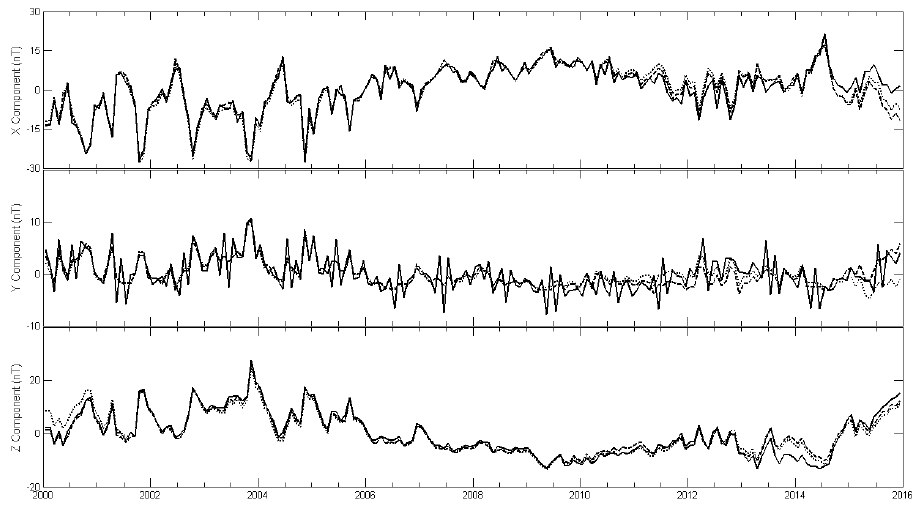
Figure 9. The external contribution to the NGK observatory, calculated as shown in the text for three models: POMME-9 (solid line), EMM2015 (dashed line) and CM5 (dotted line).